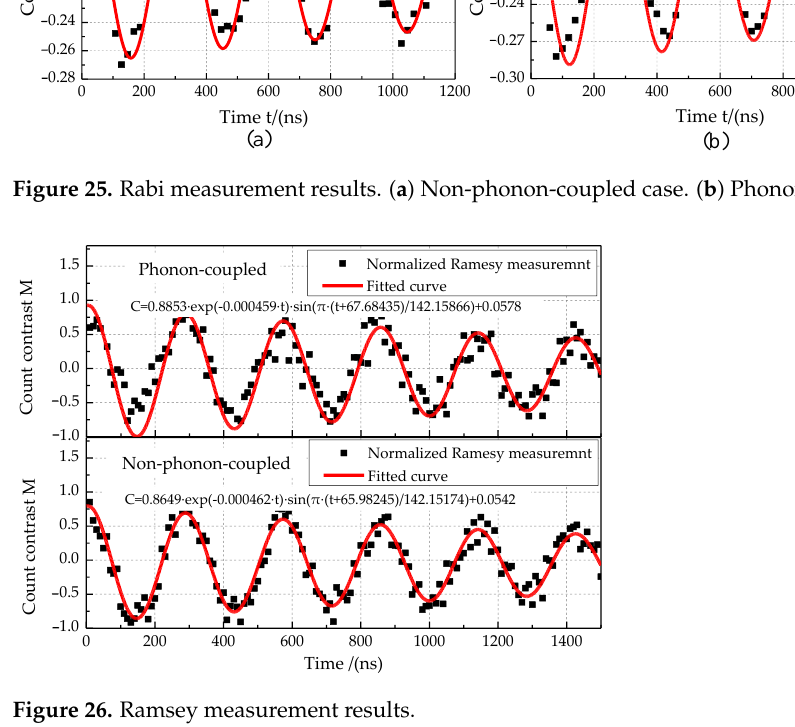
Figure 26. Ramsey measurement results.